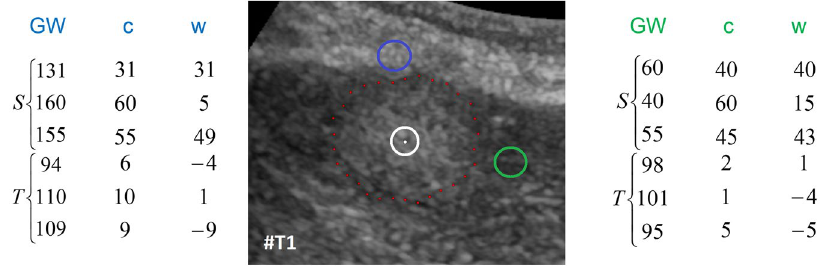
Figure 6. Principle of generating the weighted edges between the nodes and the source/sink with an average gray value (for this example 100) sampled around the user-defined seed point (white) in the area of the white circle (US image in the middle). The example on the left belongs to nodes that have been sampled along a ray that runs into a brighter area (blue circle). The example on the right belongs to nodes that have been sampled along a ray that runs into a darker area (green circle). GW are the underlying gray values and the costs c are absolute values between the average gray value (100) and the sampled values behind the nodes (e.g. |100– 131| = 31, |100–160| = 60). Finally, the weights w that are assigned to an edge between a sampled node and the source or sink is calculated between two adjacent absolute cost values, e.g. 10–9 = 1. The signs (negative/ positive) define if a node is bound to the source or the sink, except for the very first and last nodes (31, 9, 40 and 5), which are bound with their absolute weight values to the source ( − 9, − 5) or sink (31, 40), respectively.